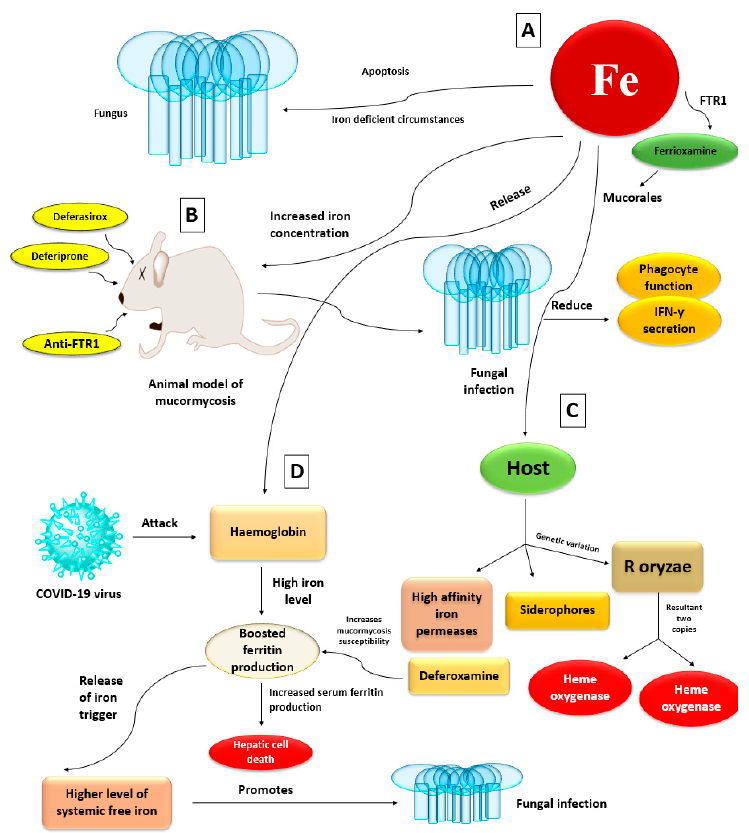
Figure 5. Schematic diagrams of Iron uptakes roles; ( A ) Higher level of Iron (Fe) leads to fungal growth, whereas fungal undergoes apoptosis in iron deficient circumstances; ( B ) Increase level of iron in animal model cause fungal infection, due to the reduction of phagocyte function and IFN- γ ; ( C ) In the host body the Mucorales obtain iron via three mechanisms: High affinity iron permeases, siderophores and R. oryzae . The R. oryzae promotes the existence of two copies of hemeox-